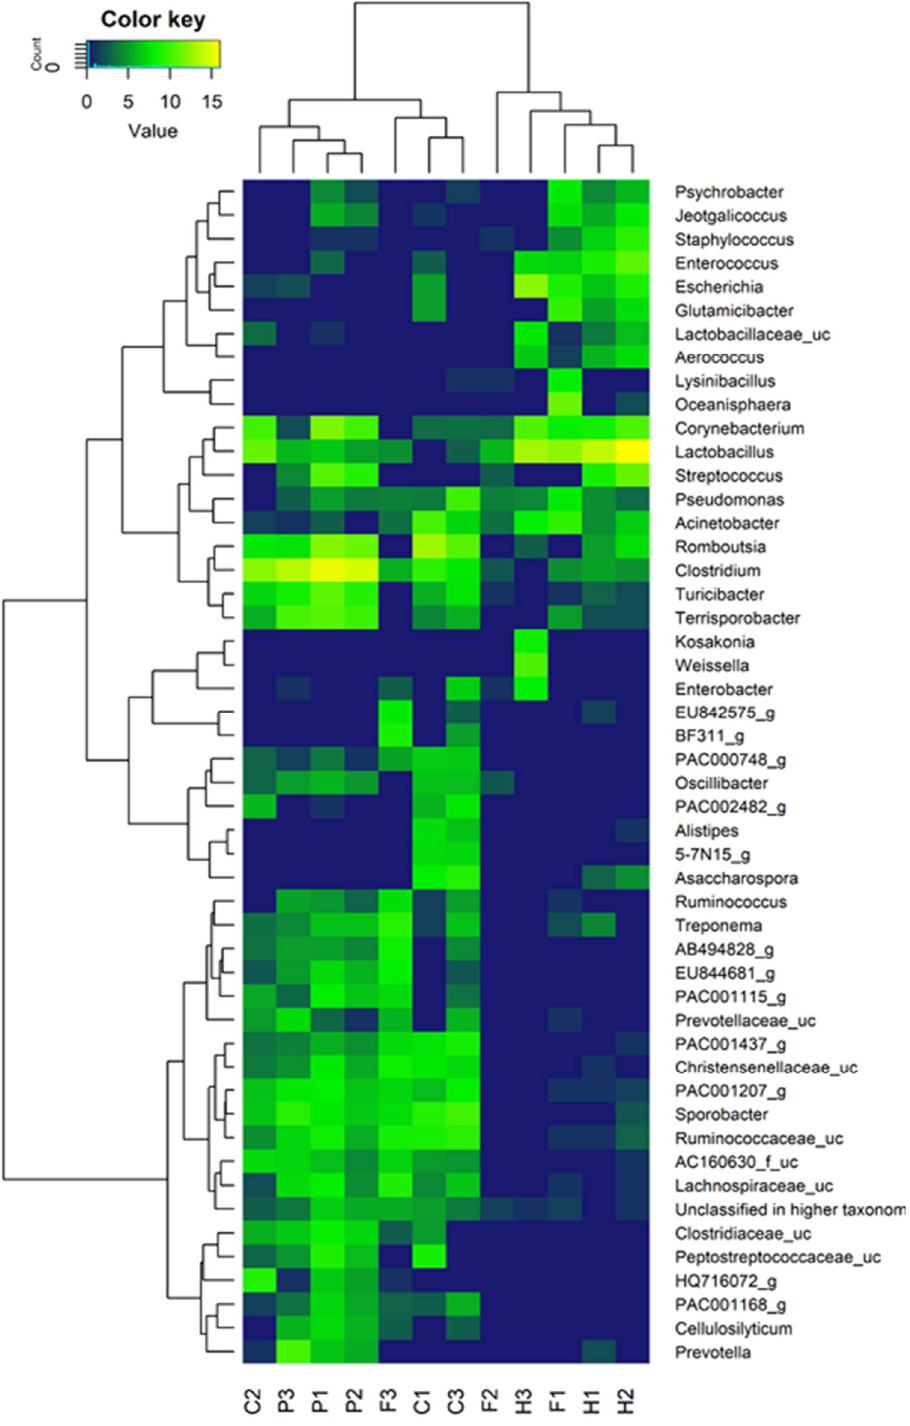
Figure 3. Genus Level Distribution of Bacterial Communities in Different Animal Manure Sam- ples.